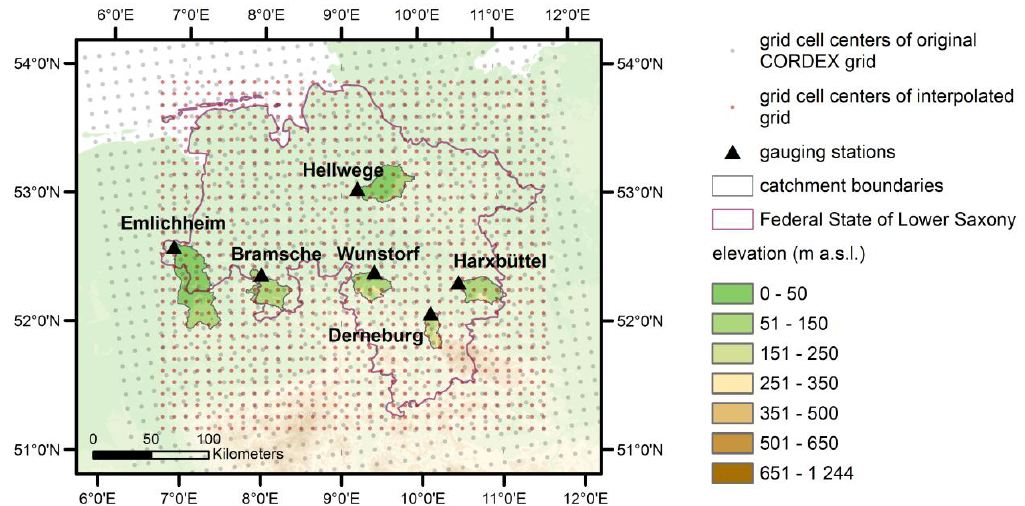
Figure 1. Grid cell centers of the original Coordinated Downscaling Experiment for Europe (CORDEX) grid, the interpolated 10 × 10 km grid and the location of the six catchments.